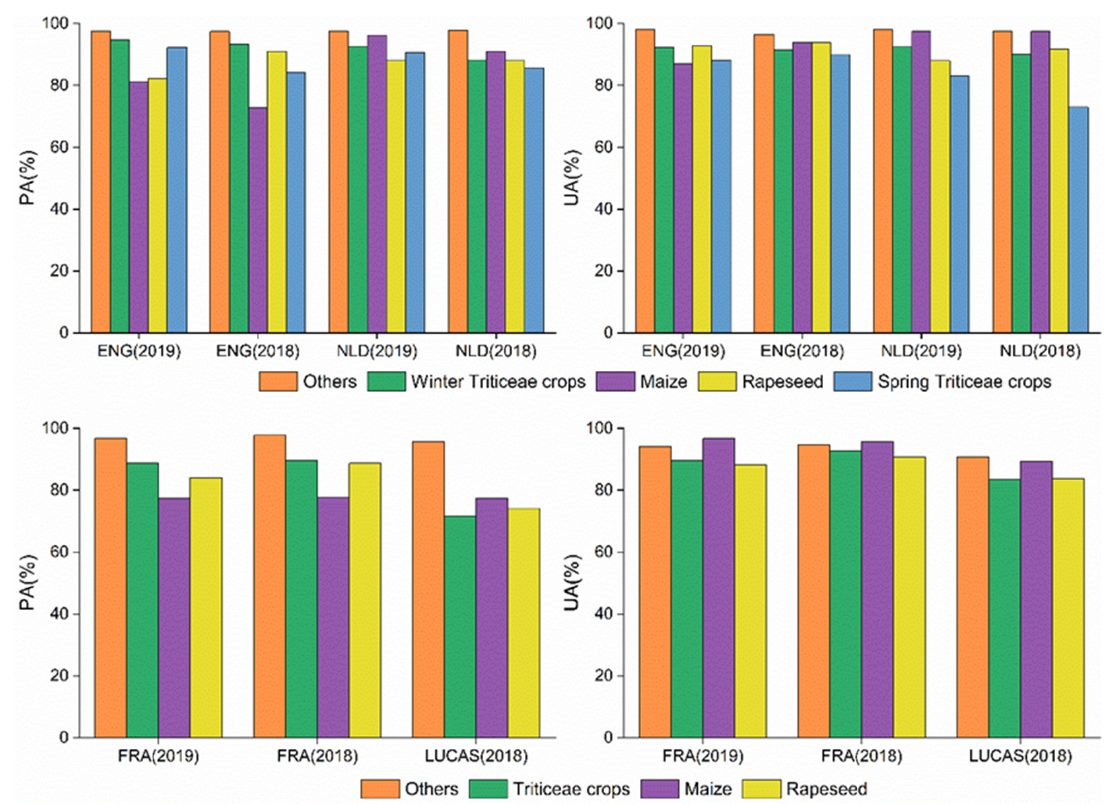
Figure 4. Validation results of the resultant crop maps. ENG: England, NLD: The Netherlands, FRA: France, PA: producer’s accuracy, UA: user’s accuracy. Table 3. Classification accuracy of the point-based validation for England and the Netherlands.